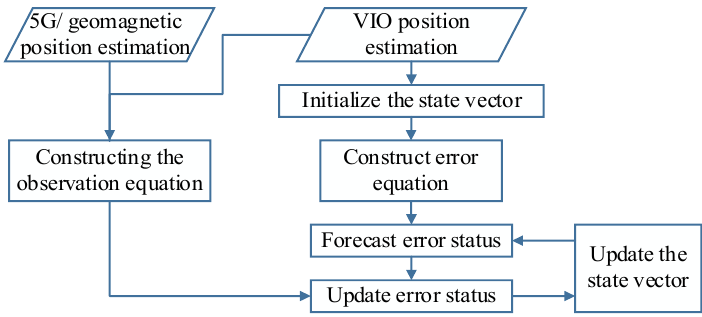
Figure 8. Combined positioning process.